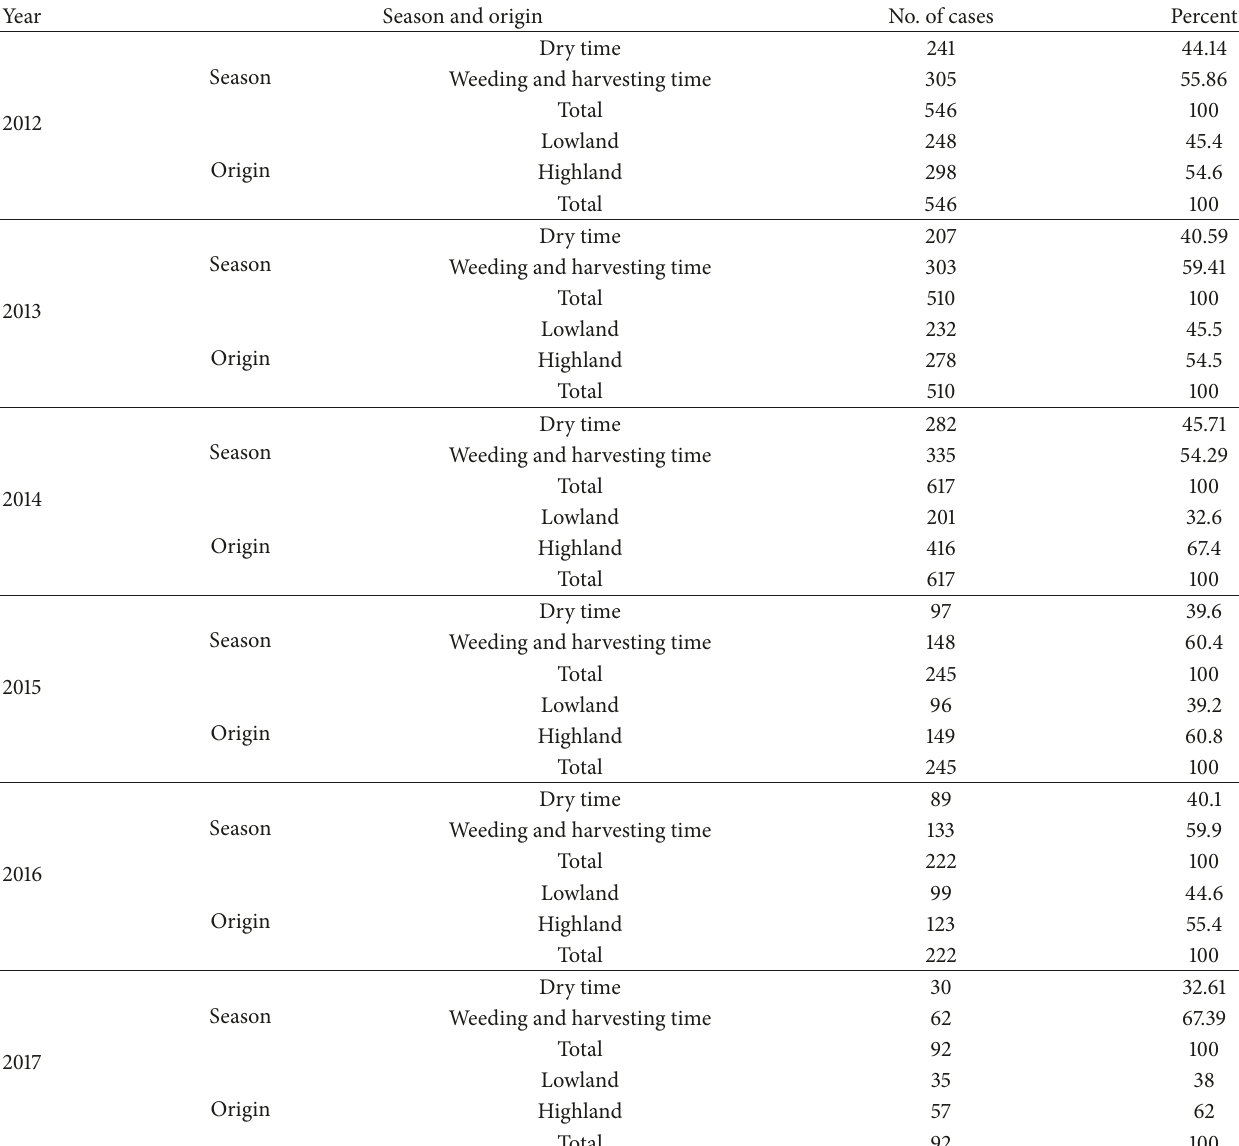
Table 2: Trends of leishmaniasis in relation to season and